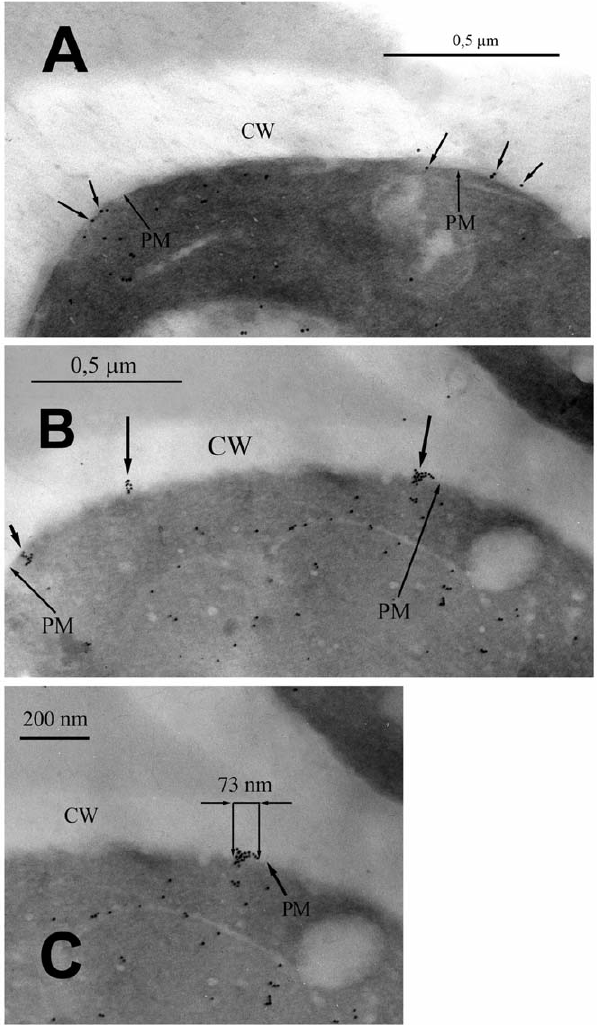
Figure 1. Immunogold labeling of Pma1 in the plasma membrane of S. cerevisiae SEY6210 . (A) – glucose-starved cells, Pma1 was distributed in the membrane as single structures; (B) – cells that had metabolized glucose for 15 min, Pma1 formed large bunch- like complexes; (C) – enlarged fragment of photograph (B) CW=cell wall; PM=plasma membrane.